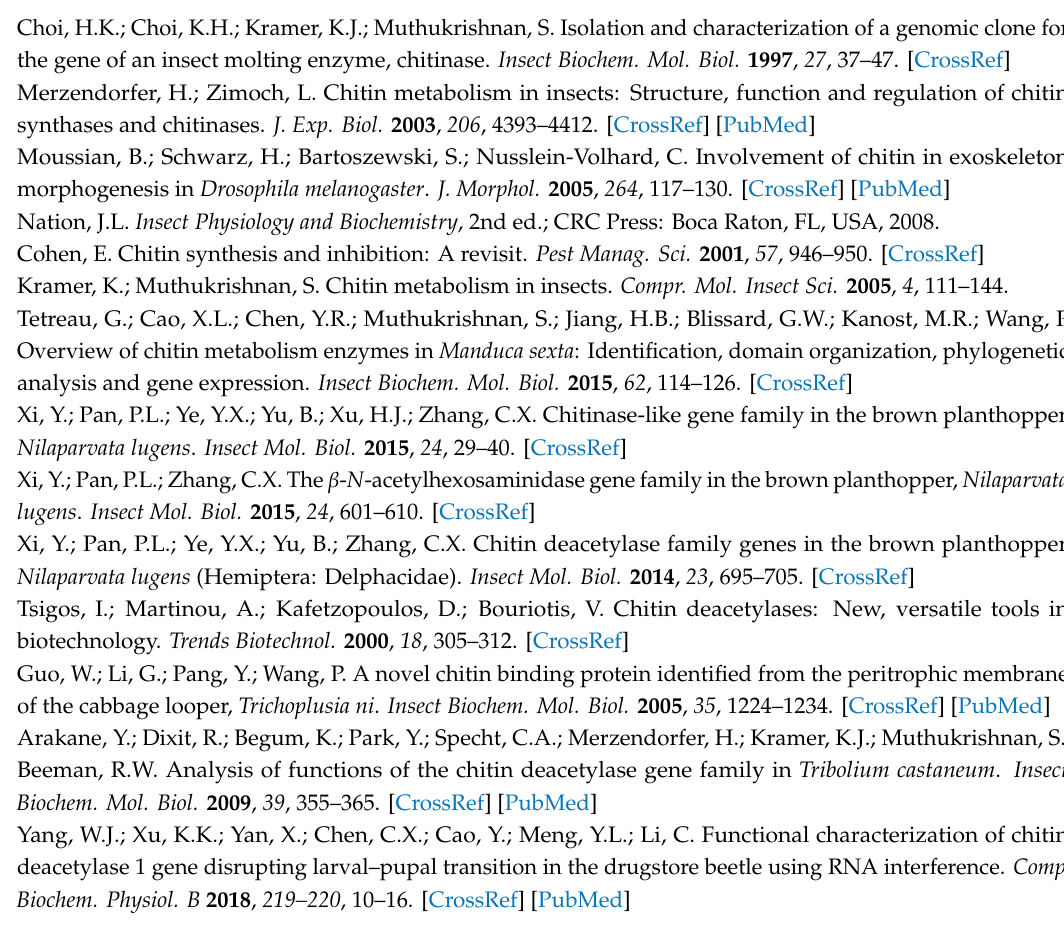
s1, Table S1: Details of chitin deacetylase sequences used for phylogenetic analysis, Table S2: Primers used in this